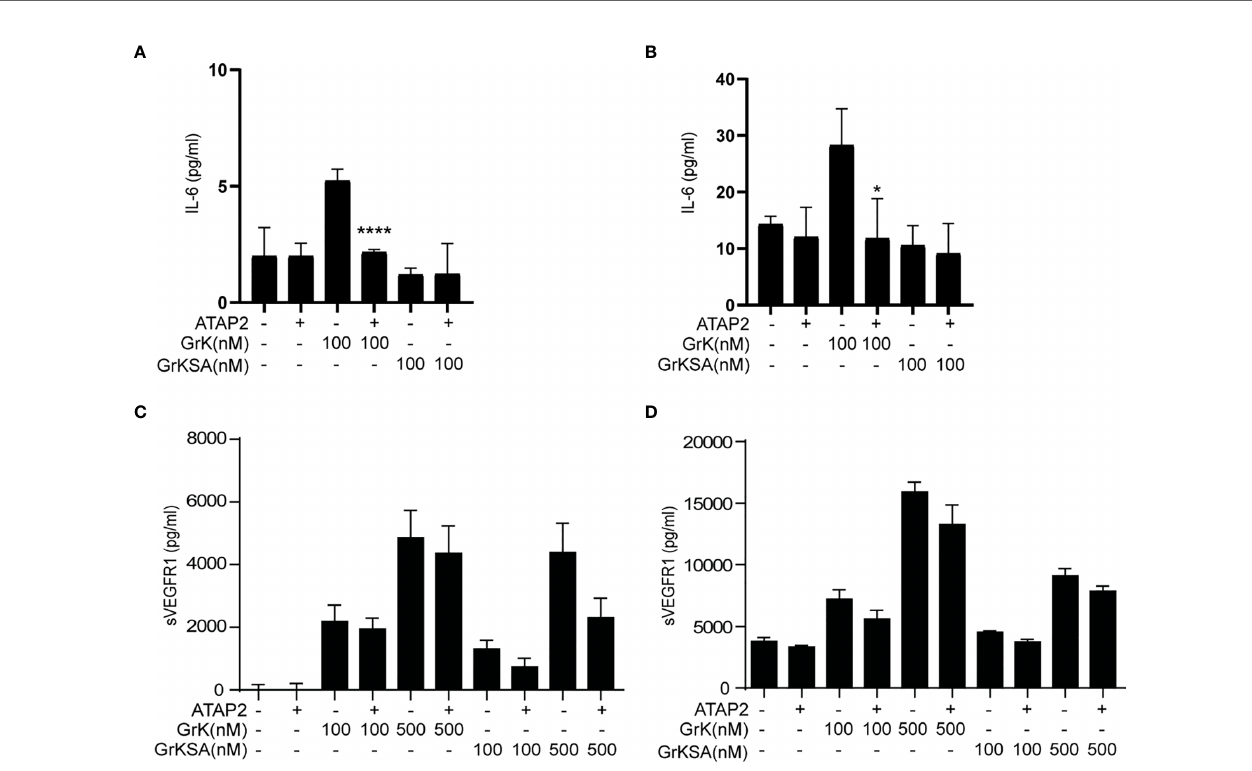
FIGURE 4 | sVEGFR1 release is not PAR-1-dependent. HUVECs were treated with different concentrations of GrK or GrKSA with or without PAR-1 inhibitor ATAP2. IL-6 was used as a positive control for PAR-1 dependent cytokine release after (A) 6h and (B) 24h of incubation. After (C) 6h and (D) 24h of incubation with GrK(SA) no PAR-1 dependent release of sVEGFR1 was seen. Results are depicted as mean ± SEM,n=3. *P < 0.05; ****P <0.0001, compared to its condition without ATAP2.